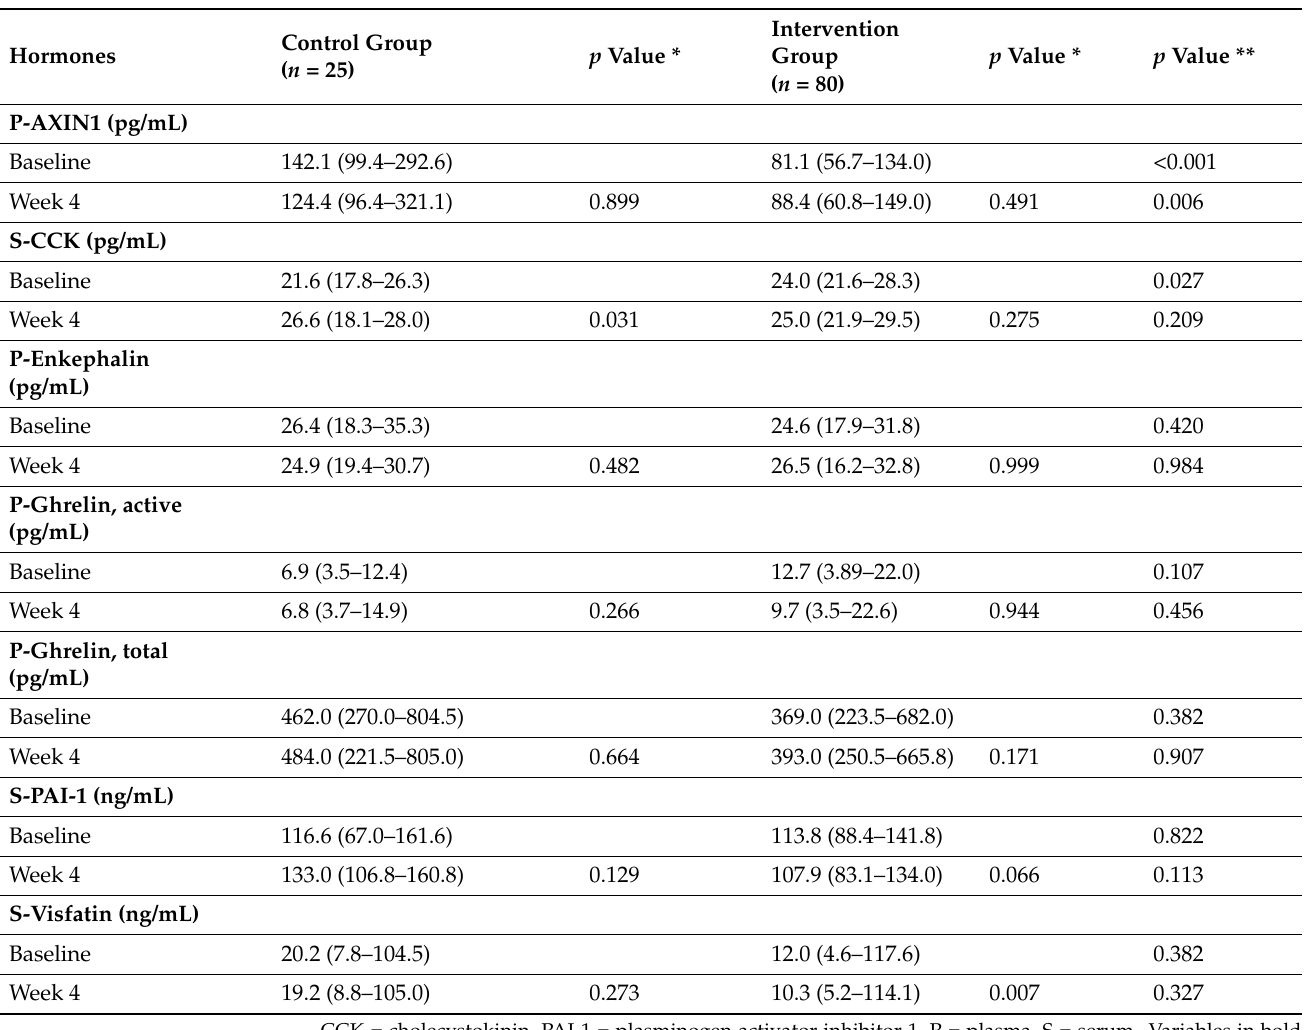
Table 6. Levels of AXIN1 and hormones prior and after a 4-week dietary intervention with a starch- and sucrose-reduced diet